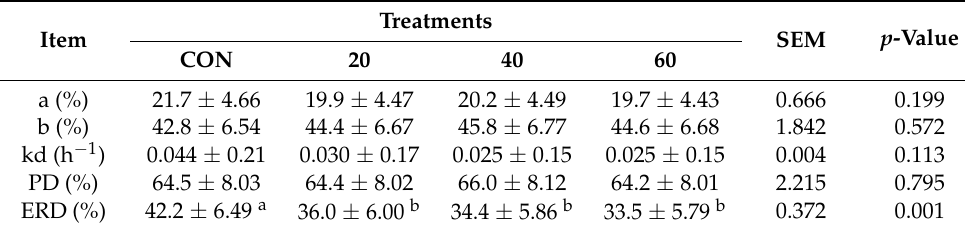
Table 5. In situ rumen degradation kinetics, potential degradability and effective degradability of rations.